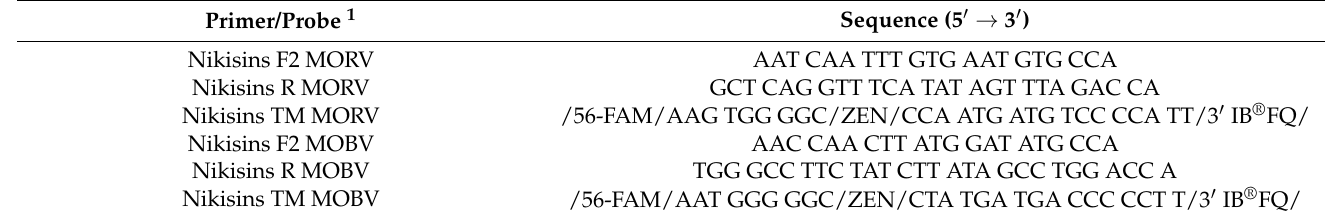
Table 1. PCR primer and probe